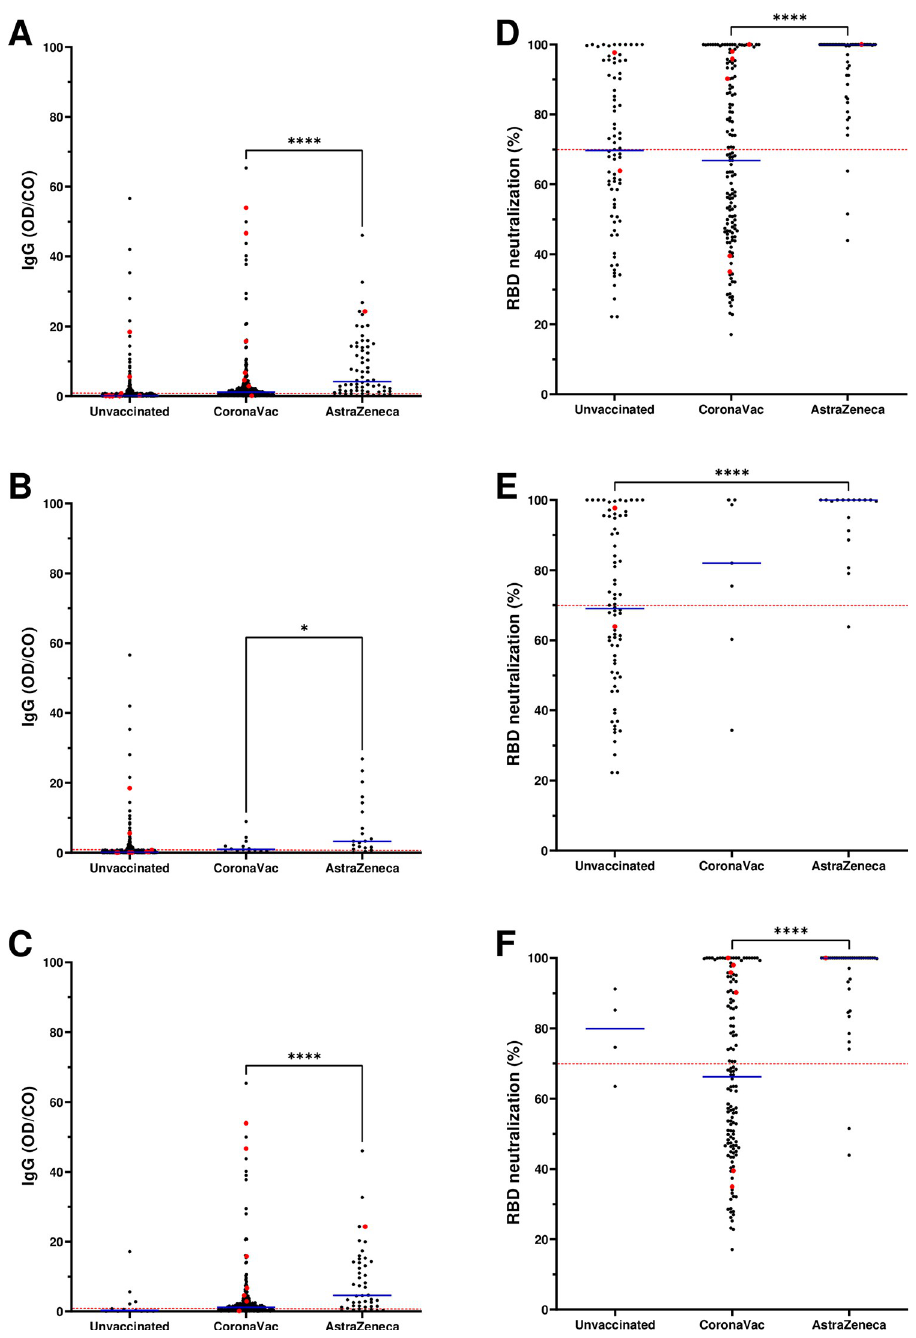
Fig 3. Comparisons among unvaccinated and fully immunized groups according to their anti-SCOV2 IgG and NAb levels. A, B and C) Anti-SCOV2 IgG serum levels according to age (overall, < 60 and � 60 years old, respectively). D, E and F) NAb serum levels of overall, < 60 and � 60 years old groups, respectively. Red line represents the cut offs ( � 1.0 and � 70%). Blue lines stands for the median of each group. Red dots represent SARS-CoV-2 RT-PCR positive individuals in each group. � p value < 0.05; ���� p value <